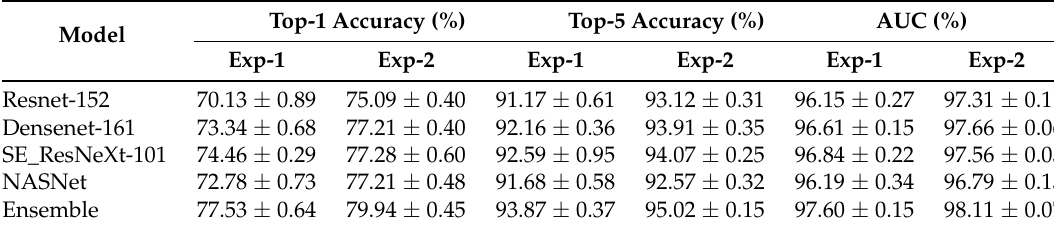
Table A1. Detailed results of 23-ary classification for individual classifiers and their ensemble on DermNet.